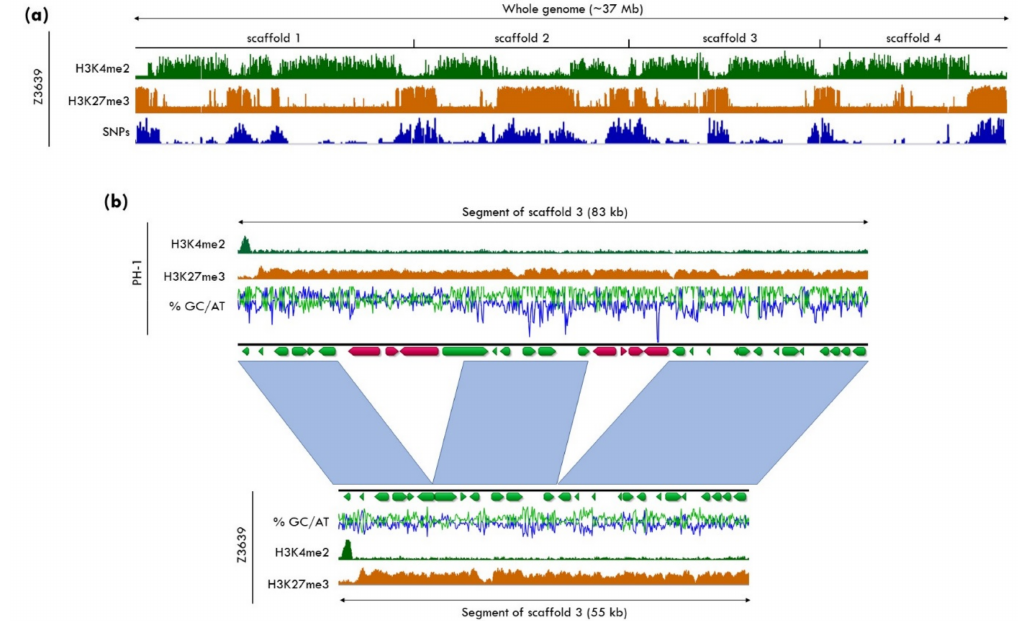
Figure 3. VariabilityofH3K27me3regionsindifferent Fusariumgraminearum isolates . ( a )Thegenomeof F. graminearum isolate Z3639 consists of four chromosomes (scaffolds 1–4) that are largely divided into